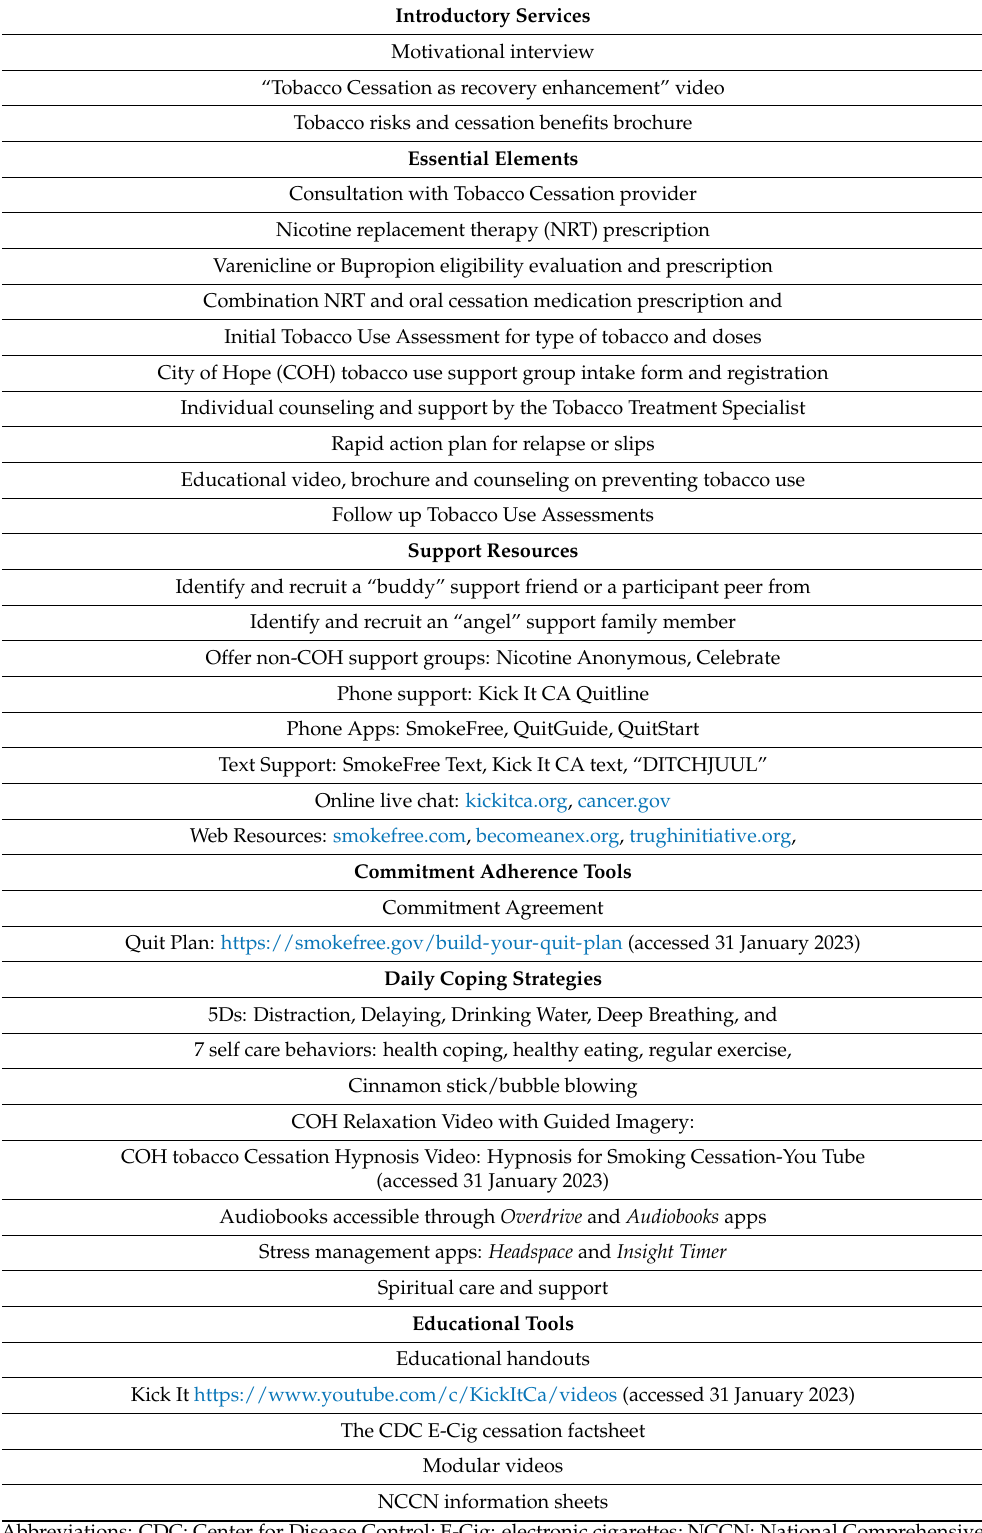
Table 3. Menu of Personalized Pathway to Success (PPS)